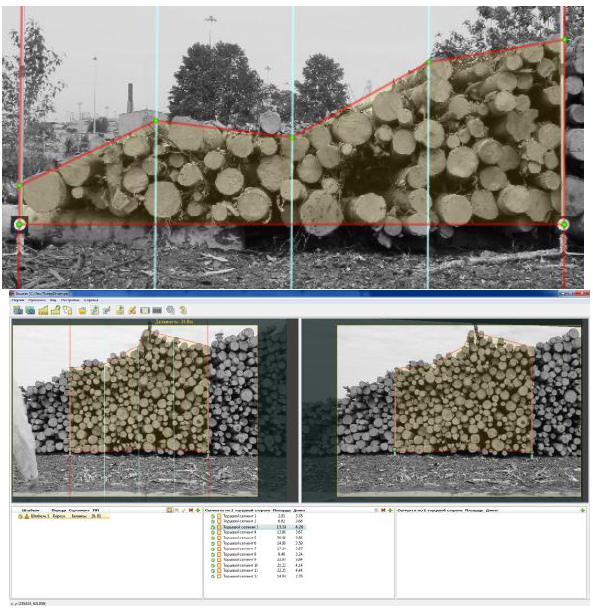
Figure 11. Sections area determination The next segment is formed by moving the left bar along the log stack, the right bar being fixed at its place. The described procedure is performed until reaching the end of the log stack. After measuring all segments in a stack overall stack volume is calculated and final report is generated (Figure 12).